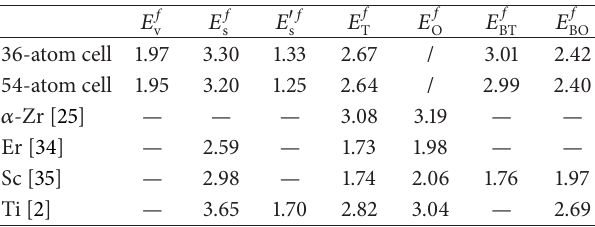
Table 2: Vacancy formation energies (in eV) for a single He atom positioned in different sites. All the configurations are found to be stable, except O, which is unstable and transfers to BO. 𝐸 𝑓 represents the formation energy of a Zr vacancy and 𝐸 󸀠𝑓 the formation energy of a substitutional He atom in a preexisting Zr